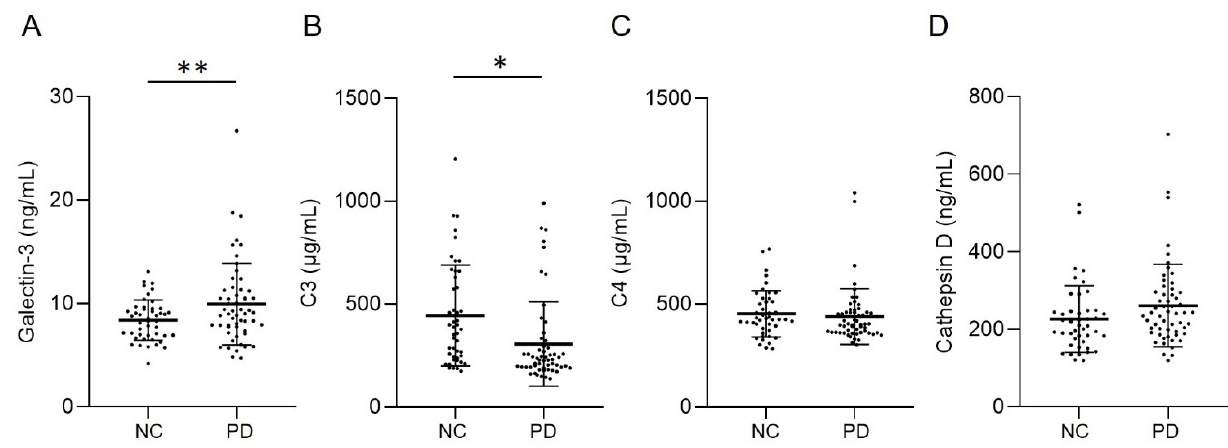
Figure 1. Plasma levels of ( A ) galectin-3, ( B ) C3, ( C ) C4, and ( D ) cathepsin D in patients with Parkinson’s disease (PD, n = 56) and normal controls (NCs, n = 46). Lines depicted the mean ± standard deviation (SD) of each group. Statistically significant differences between two groups: * p = 0.002, ** p =